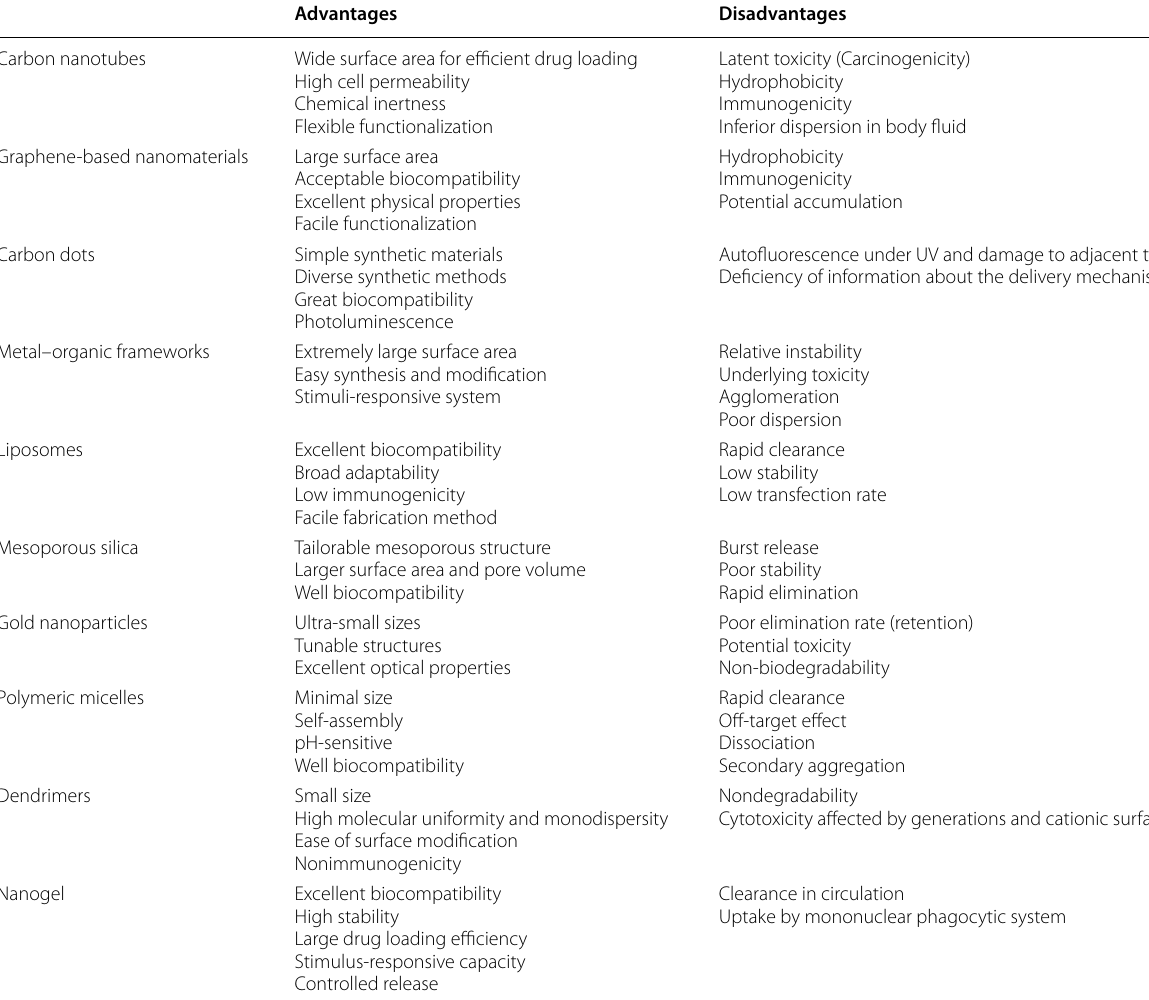
Table 1 The advantages and disadvantages of various nanoparticle systems